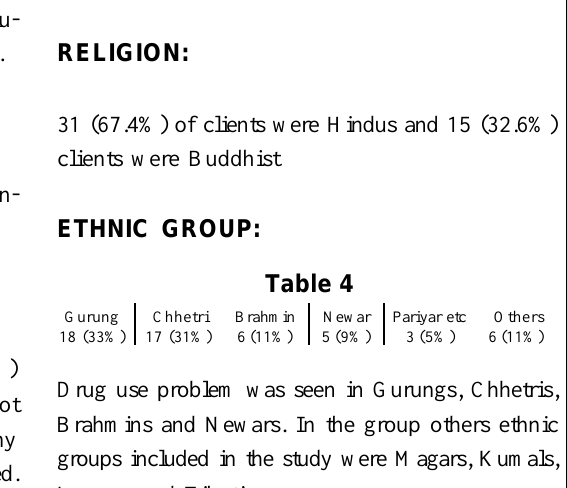
Drug use problem was seen in Gurungs, Chhetris, Brahmins and Newars. In the group others ethnic groups included in the study were Magars, Kumals, Lamas, and Tibetians.